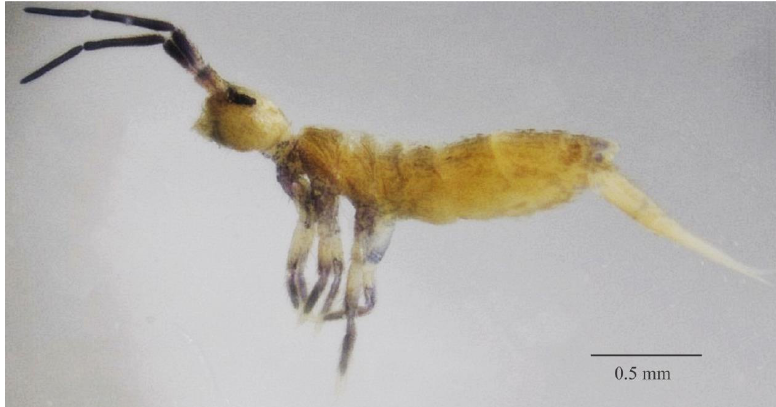
Figure 1. Dicranocentrus abestado sp. nov. habitus, specimen fixed in ethanol (lateral view). Insects 2020 , 11 , x FOR PEER REVIEW